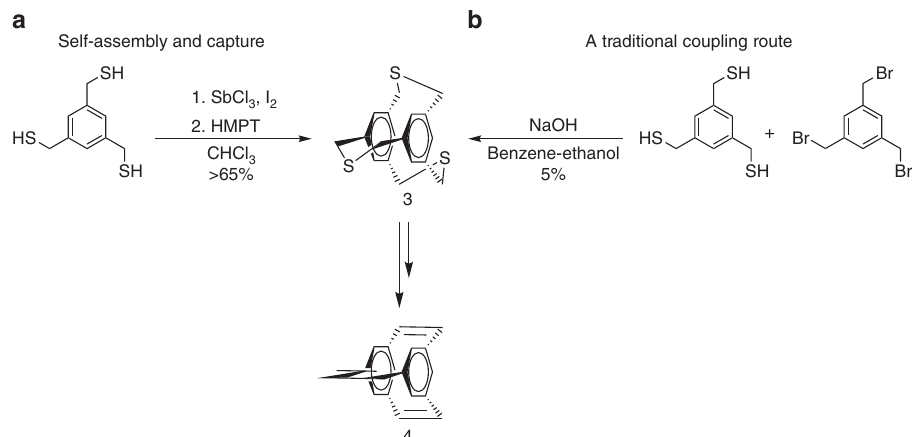
Figure 3 | Self-assembly and capture of a known cyclophane. ( a ) Self-assembly of H 3 L 3 (1mol SbCl 3 , 1.2mol I 2 ; 69%) followed by capture (95%) by sulfur extrusion with HMPT (4mol) provides known trithiacyclophane 3 in overall 65% yield. ( b ) A traditional stepwise route to 3 proceeds in 5% yield.